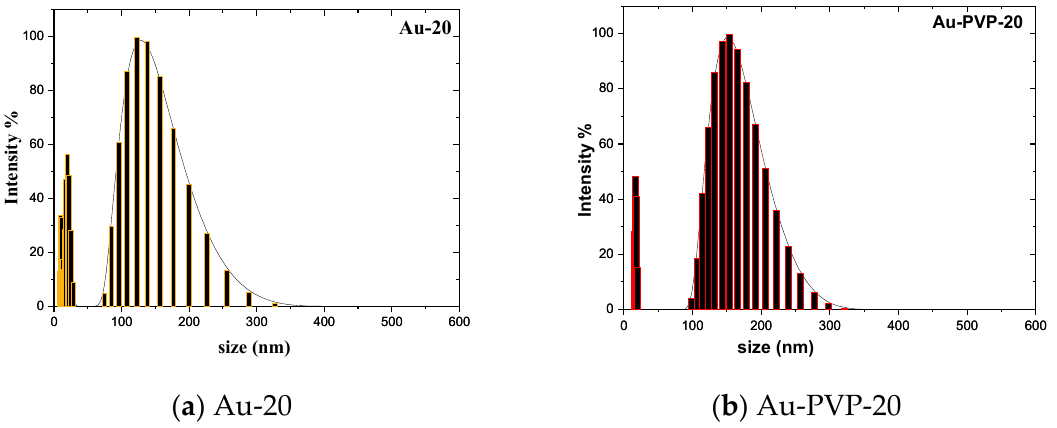
Figure 6. Intensity-particle size distribution with Dynamic Light Scattering. With PVP capping, the hydrodynamic size distribution was 15 nm to 297 nm.